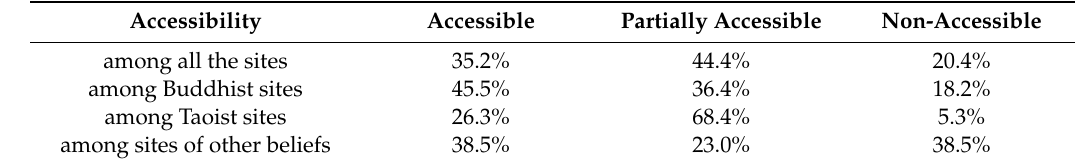
Table 3. Current status of accessibility of visited sites during fieldwork 12